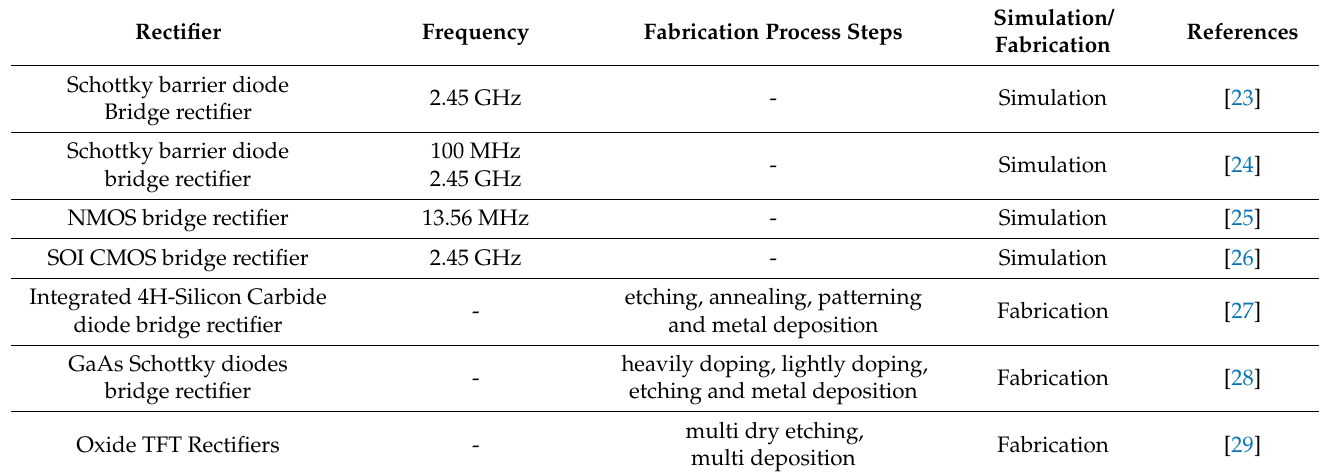
Table 1. The results reported from previous works on bridge rectifier.